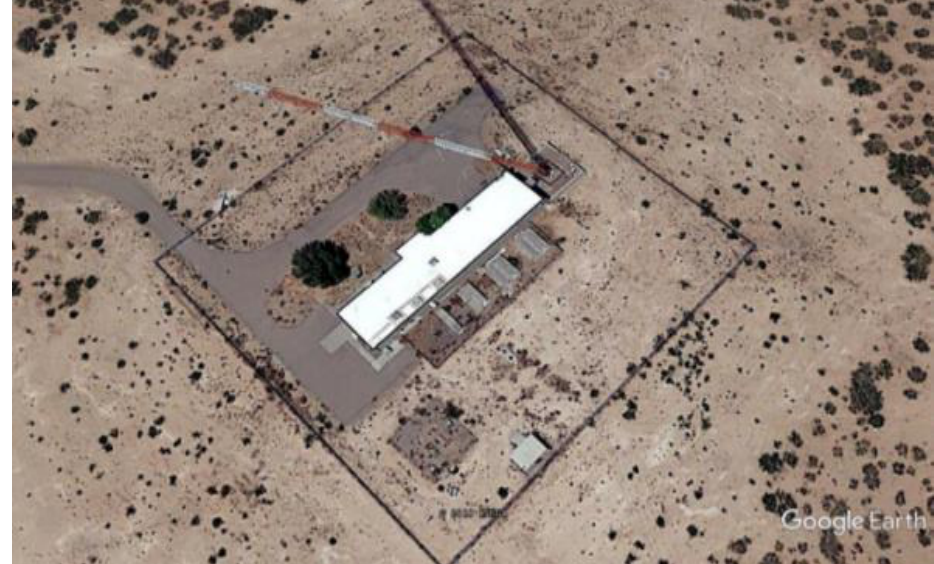
Figure 3. Satellite image of a Loran-C system transmitting antenna in the USA.